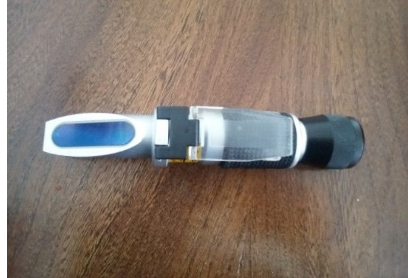
Figure 5. Manual refractometer.